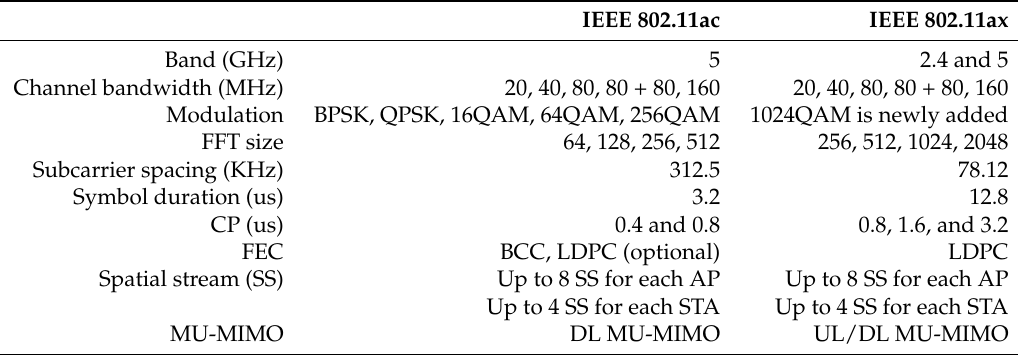
Table 1. A comparison between the IEEE 802.11ac and the IEEE 802.11ax.